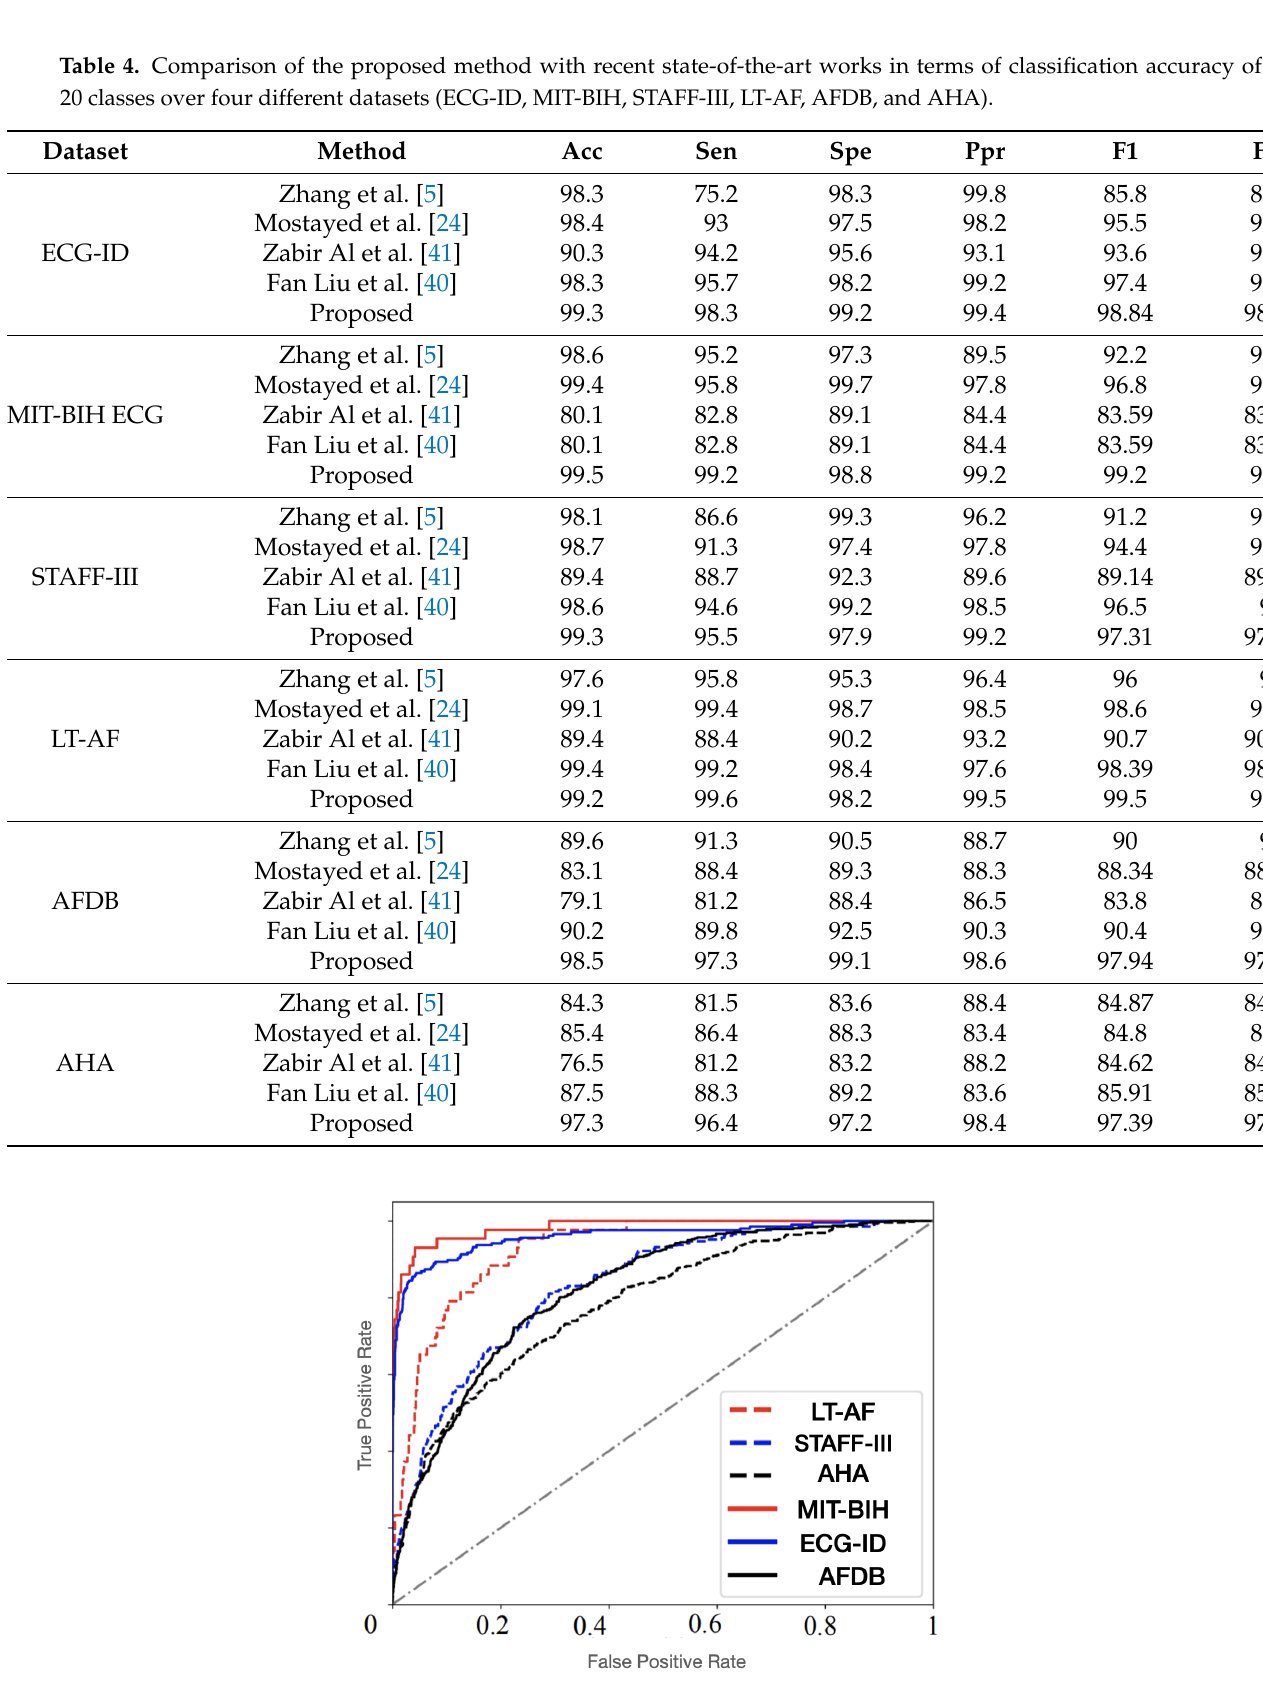
Figure 13. Receiver Operating Characteristics (ROC) classification of the proposed bi-directional LSTM network for six different ECG